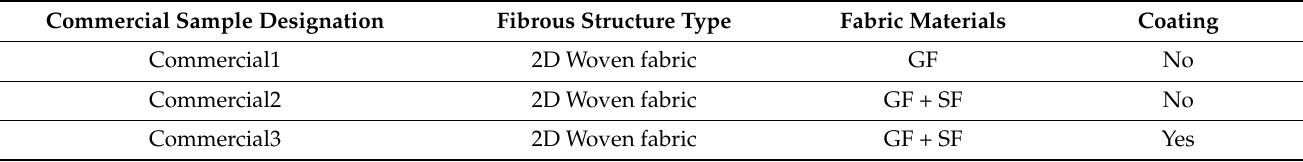
Table 4. Commercial samples’ overall